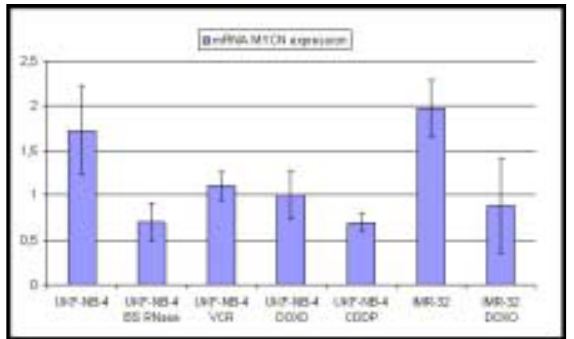
Fig. 2. Relative expression of the mRNA MYCN We cultivated UKF-NB-4 CDDP for five passages without CDDP and then performed real-time RT-PCR. Already in the first passage without CDDP, the expression of MYCN gene declines to that of UKF-NB- 4. Difference between expression of UKF-NB-4 and expression of UKF-NB-4 CDDP in the third passage without CDDP is insignificant. Our results indicate that expression of the MYCN gene in UKF-NB-4 CDDP is dependent on the presence, or absence of CDDP. We assume, that similar changes may occur in patients with HR NBL treated by